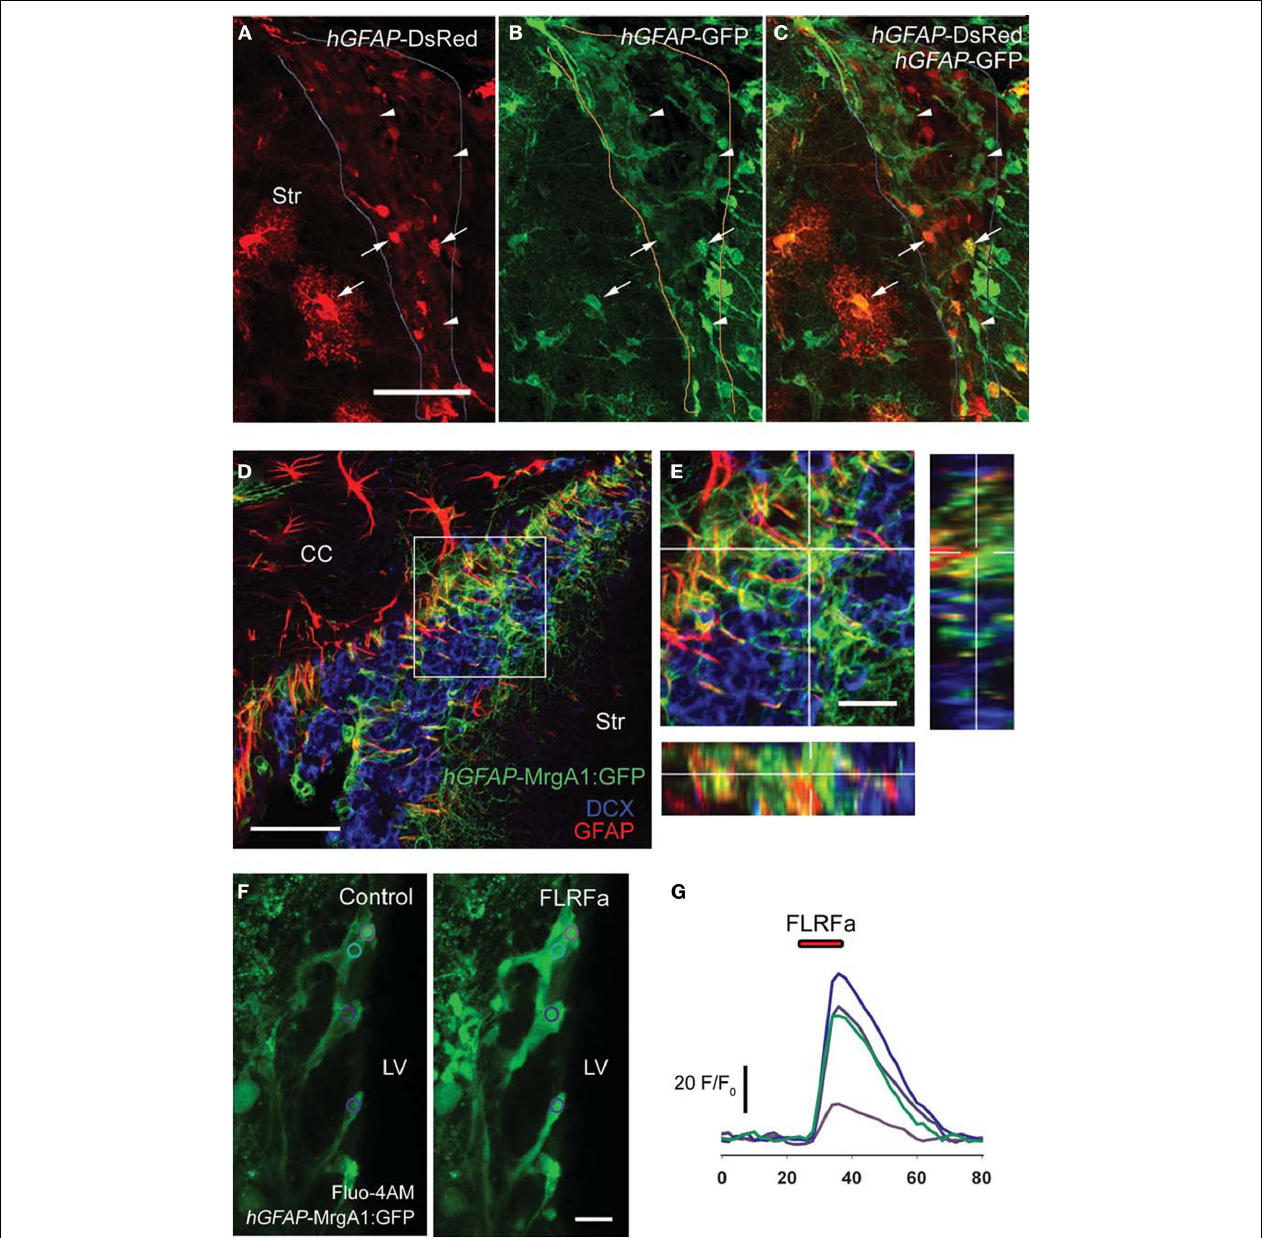
FIGURE 2 | Characterization of hGFAP -tTA-MrgA1:GFP mice in the SVZ. (A–C) Confocal z-section of a slice from a hGFAP -tTA-MrgA1:GFP/ hGFAP - DsRed mouse. The arrows point to SVZ astrocytes that are both DsRed and GFP-fl uroescent, while the arrowheads point to astrocytes that are only GFP- positive. Scale bar = 30 µm. (D) A confocal z-stack (four images, spaced by 1.5 µm) of a slice from a hGFAP -tTA-MrgA1:GFP mouse. Astrocytes express the MrgA1:GFP. GFP signal colocalized with GFAP (red) but does not